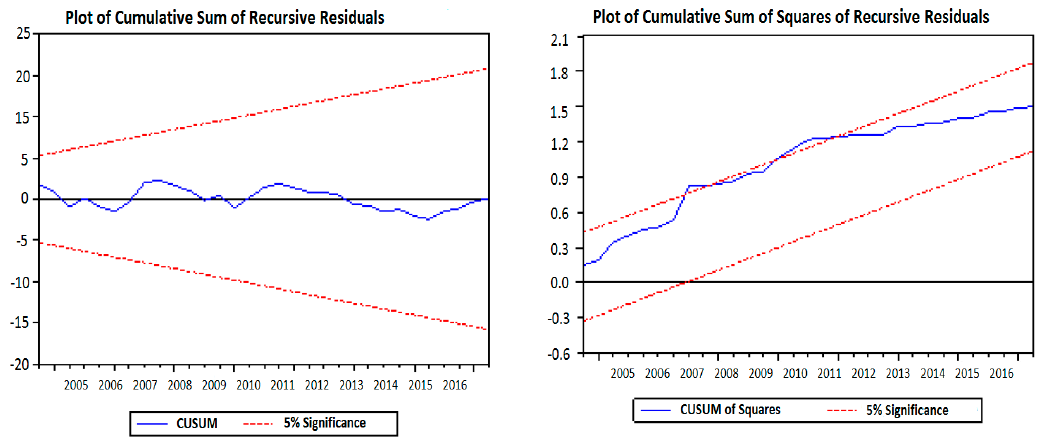
Figure 6. Stability of the coefficients of the autoregressive distributed lag (ARDL) model . Note: The straight lines represent critical bounds at 5% level of confidence. Source: data analysis was performed by the author, using EViews 11.0.